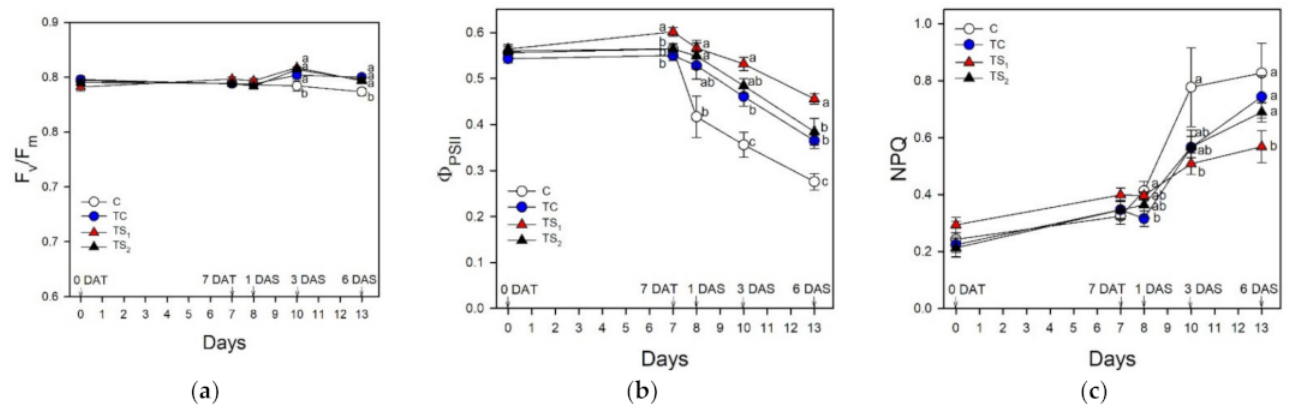
Figure 5. Chlorophyll fluorescence measurements in leaves of purple basil cv. Red Rubin at 0 and 7 days after bacterial treatment (0 DAT and 7 DAT, respectively) and at 1, 3 and 6 days after water stress (1 DAS, 3 DAS, and 6 DAS, respectively): ( a ) maximum PSII photochemical efficiency in the dark-adapted state (F v /F m ); ( b ) actual photon yield of PSII photochemistry ( Φ PSII ); ( c ) non-photochemical quenching (NPQ). Values are means ± SE ( n = 10). Different letters indicate significant differences among bacterial treatments and control (one-way ANOVA with Fisher’s LSD test, p ≤